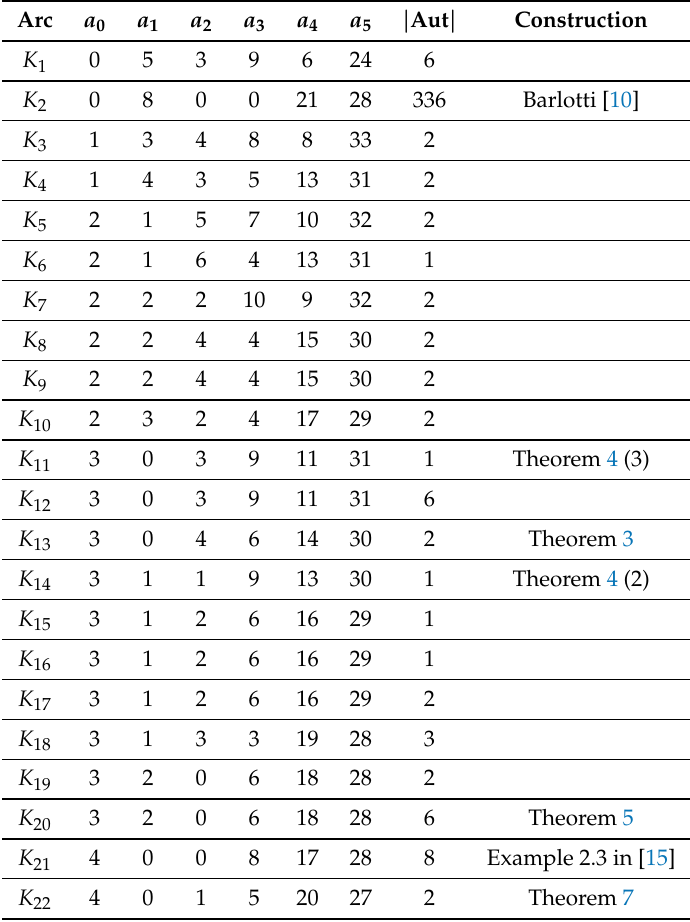
Table 3. The ( 29,5 ) -arcs in PG ( 2,7 )